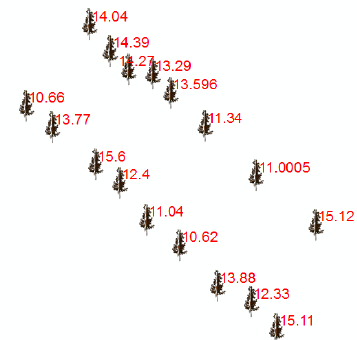
Figure 4. Map of GIS data base of extracted street trees showing locations and trees height